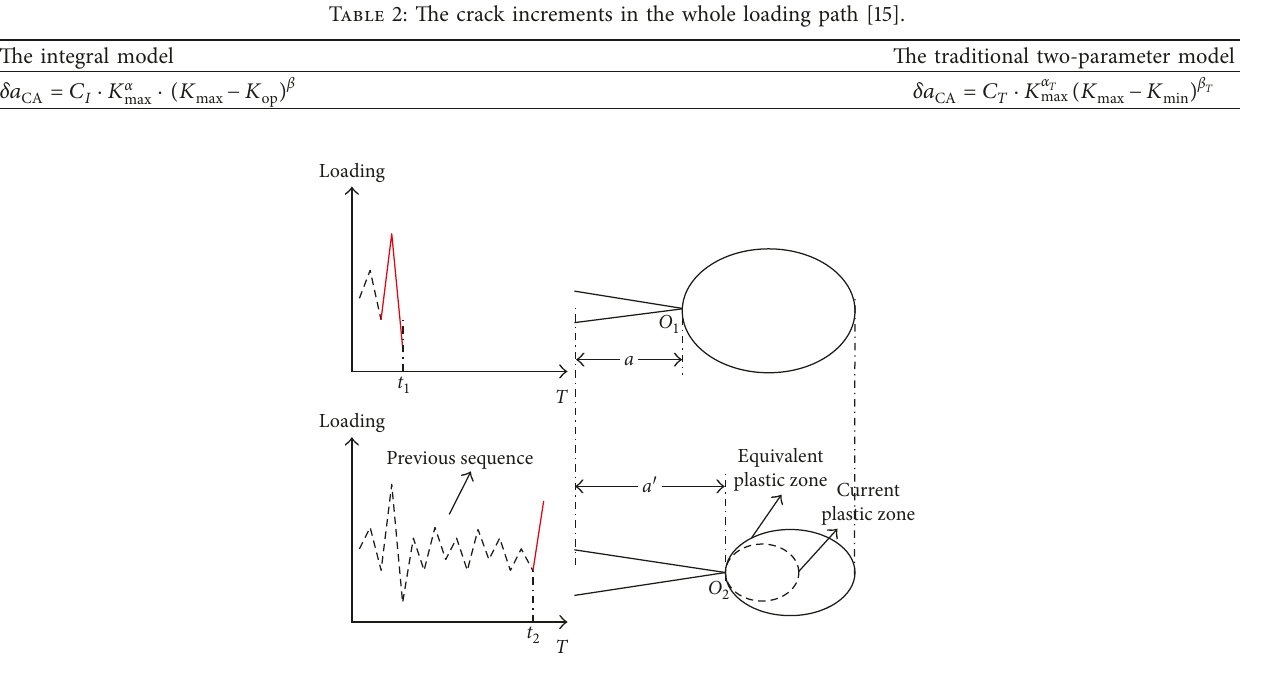
Figure 3: Schematic illustration of equivalent plastic